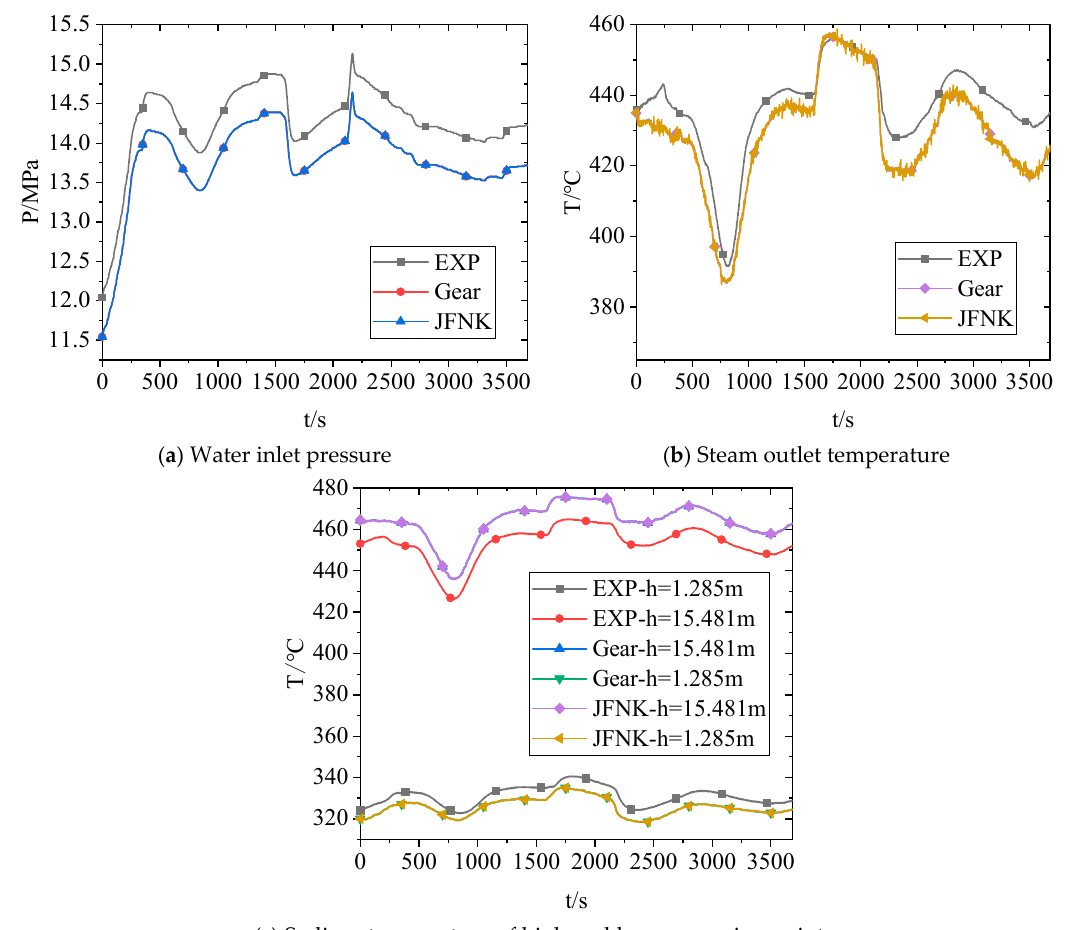
Figure 8. Multi − parameter change transient input boundary condition.